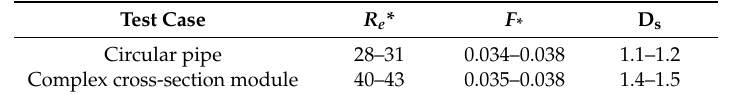
Transportable maximum sand grain size ( D s ), boundary Reynolds number ( R e ∗ ), and dimensionless shields parameter ( F ∗ ) in this experiment (discharge: 0.4 L / s, slope: 0.01, pipe material: PVC).